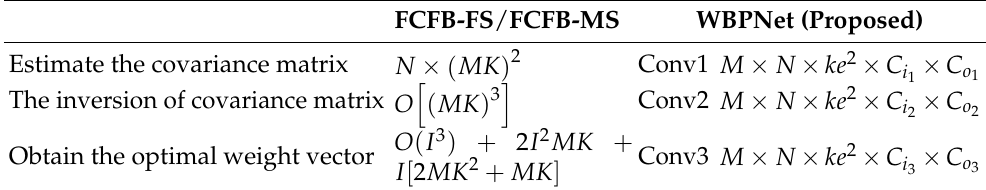
Table 3. The multiplications of the WBPNet with analytical